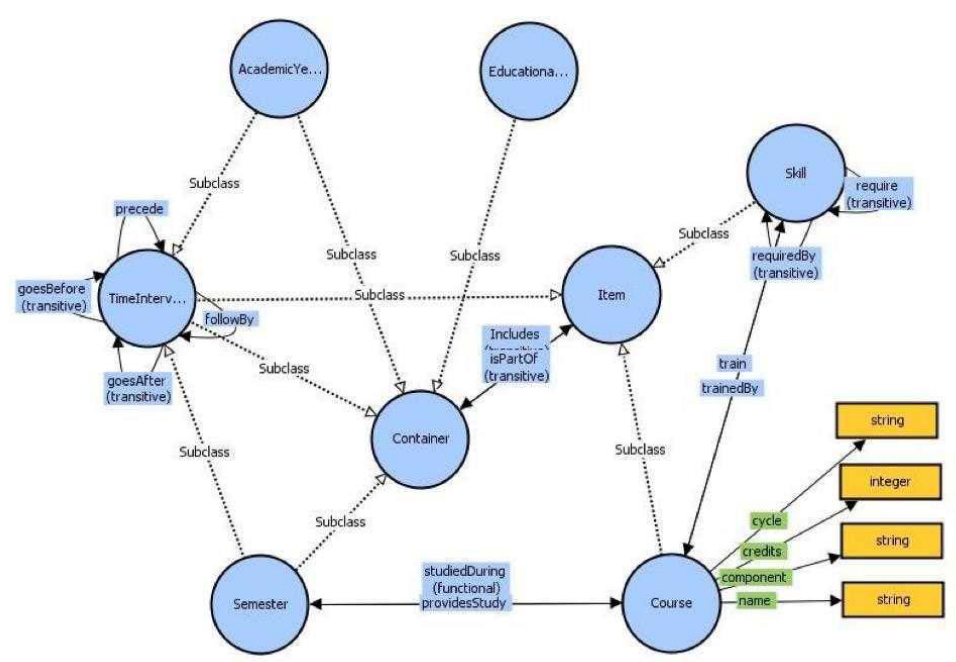
Figure 5. Semantic network graph describing the relationship between course, semester and skills.